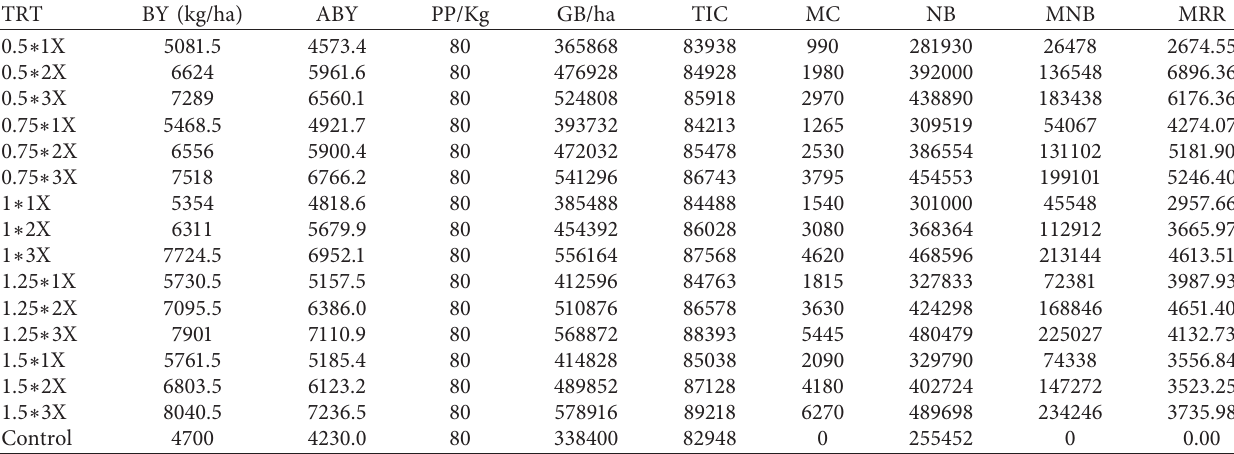
Table 8: Partial budget analysis of rate and spraying frequencies of propiconazole for the mgt of garlic rust. TRT BY